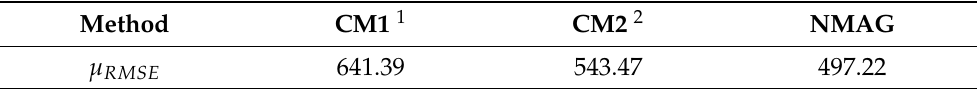
Table 3. Accuracy comparison of the µ RMSE of NMAG, Contrast Method 1 (CM1) and Contrast Method 2